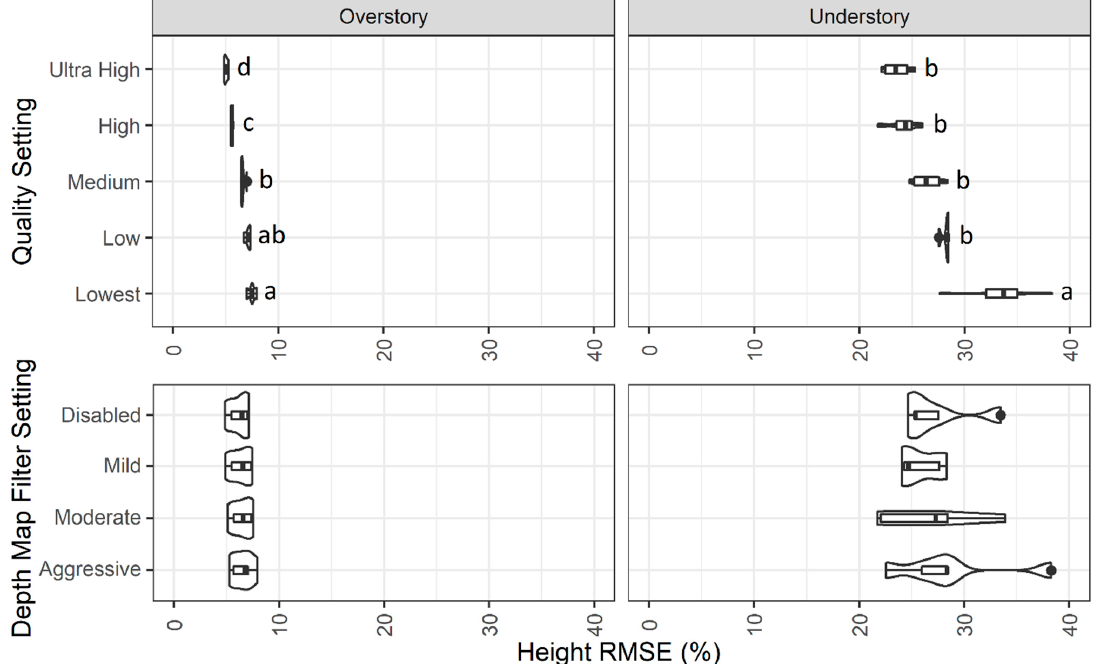
Figure 5. Influence of Metashape build dense cloud Quality and depth map filter settings on overstory and understory detected tree height root mean square error (RMSE) presented as violin plots to portray the distribution of data points. Letters represent significant differences ( α = 0.05) determined by two-way ANOVA with Tukey’s HSD test.